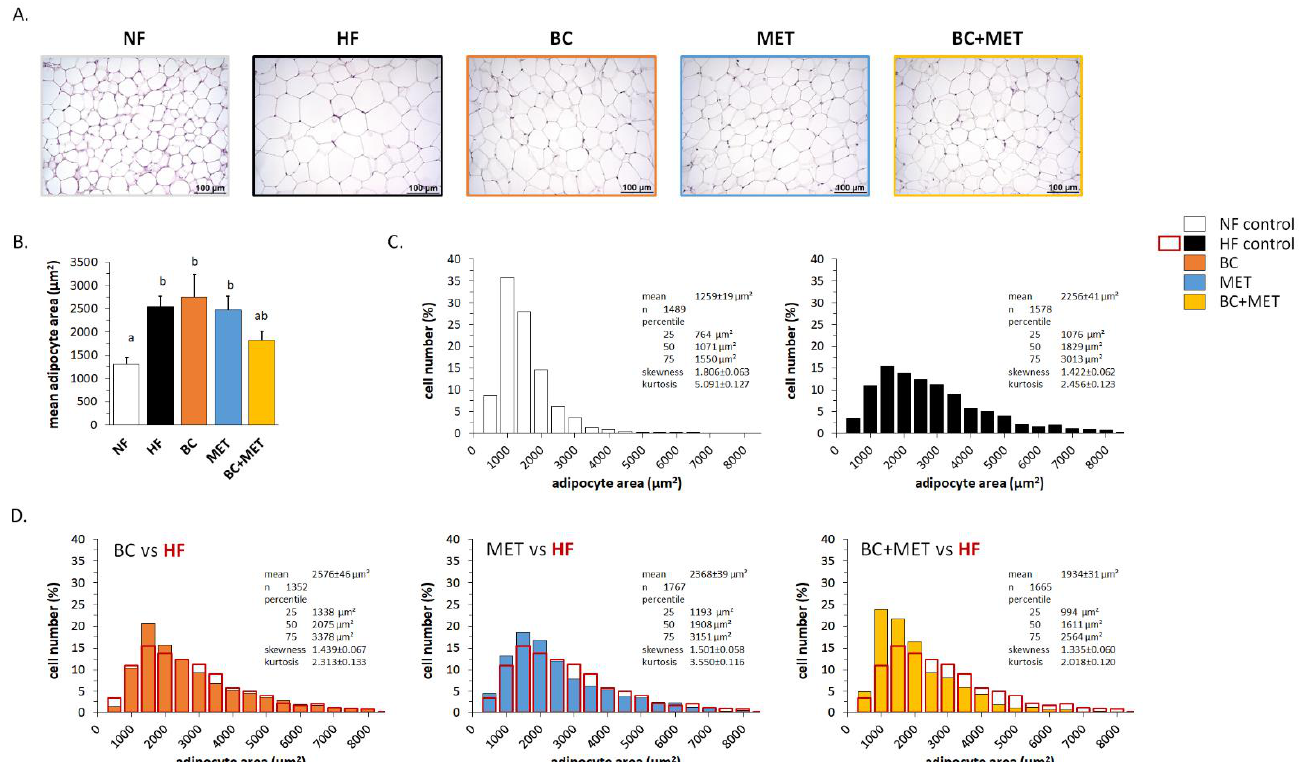
Figure 2. Representative microphotographs illustrating adipocyte size ( A ), mean adipocyte area ( B ) and distribution of adipocytes size ( C ) in iWAT at the end of the experiment. Obesity-prone mice were challenged with a high-fat diet for 4 weeks while receiving placebo (HF control) or being treated orally with BC (3 mg/kg/day), MET (100 mg/kg/day), or their combination (BC+MET); a fifth group received placebo and was kept on a normal-fat diet (NF control). Data are means ± SEM of five to seven animals per group. In B, to compare between groups, one-way ANOVA followed by Tukey’s Honest Significant Difference post hoc test was used: b ars not sharing a common letter (a and b) are significantly different (a≠b) ( p < 0.05). In ( C , D ), between 200 and 300 cells per animal were included in the analysis of the distribution of adipocytes size. The area of individual adipocytes was measured using a quantitative morphometric method at 20× magnification with the assistance of Axio Vision software. Adipocyte size distribution was statistically different with p < 0.001 between the NF control and all HF groups, and between the HF control and HF treated groups, except for the MET group were p = 0.029, according to the Kolmogorov – Smirnov test. In ( D ), the distribution of adipocytes size of HF control group is shown overlapping the one of each HF treated group.